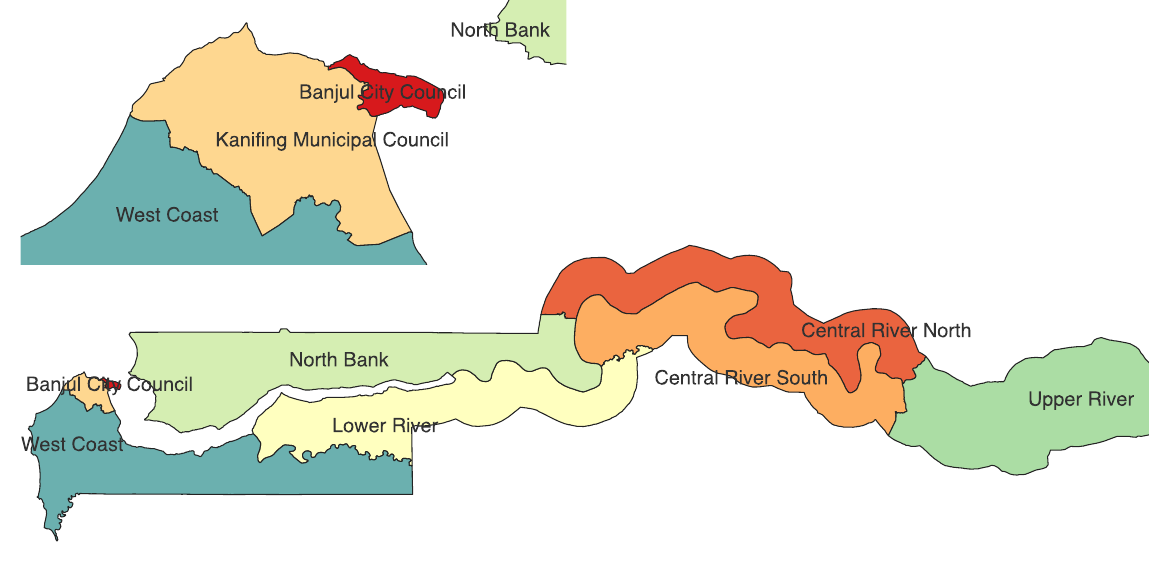
Figure 2. Map showing The Gambia’s six regions. Map was created using The Gambia’s administrative national and subnational boundaries shapefile downloaded from https:// data. humda ta. org/ datas et/ cod- ab- gmb?—an opensource humanitarian data exchange using QGIS version